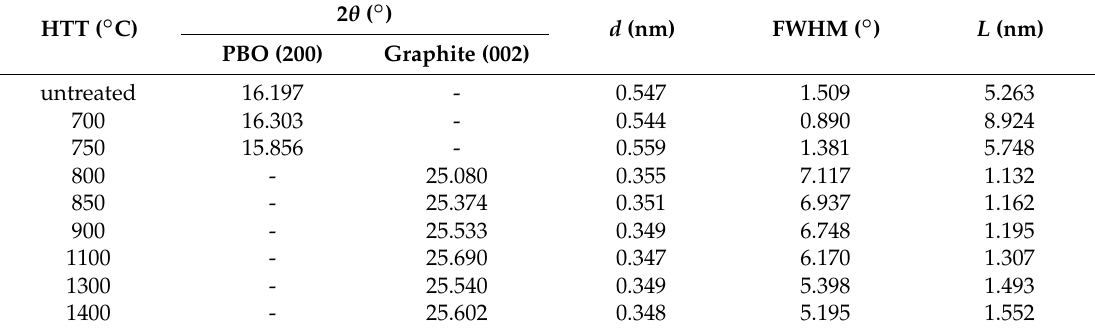
Table 4. XRD parameters obtained from data analysis. Legend: FWHM, full width at half maximum. HTT (°C)